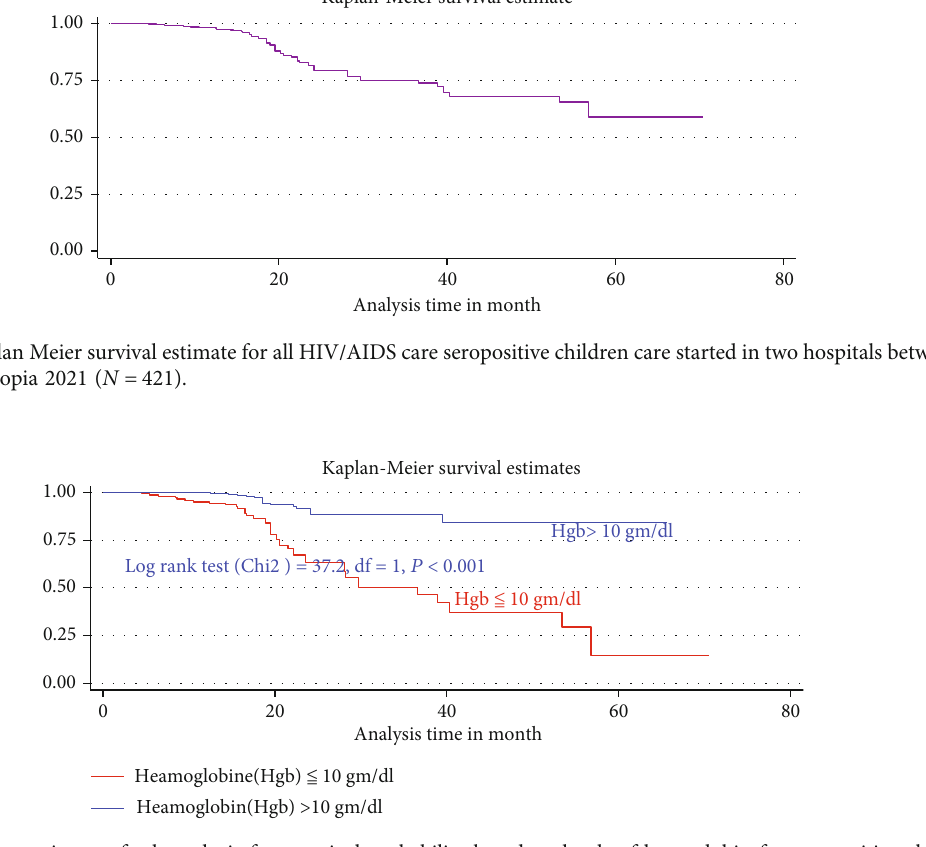
Figure 4: Kaplan Meier estimate of tuberculosis-free survival probability based on levels of hemoglobin for seropositive children, North West Ethiopia 2021.